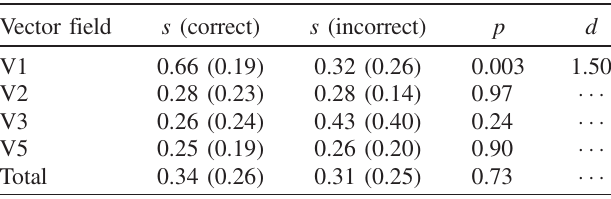
TABLE V. Average symmetry scores s (with standard deviation in parenthesis) for correct and incorrect responses by vector